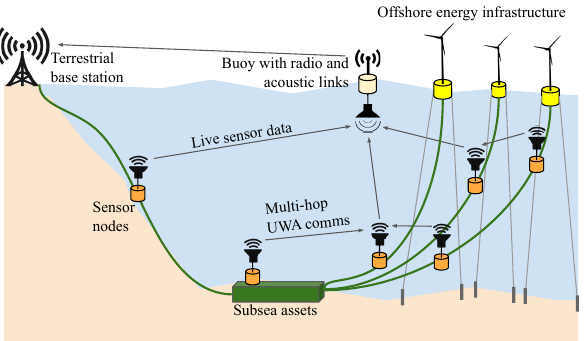
Figure 1. Example of an UWA sensor network deployment for monitoring offshore energy